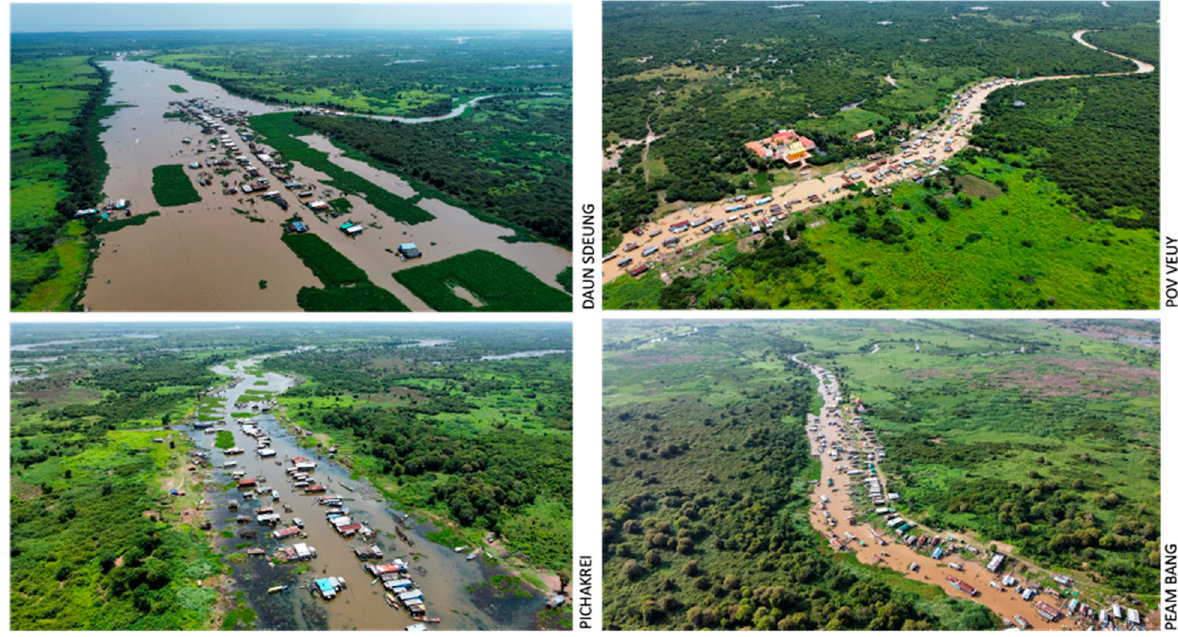
Figure 7. Subtle differences of land − water − vegetation compositions. The widths of the waterways and the microtopography greatly influences the configuration of the villages. (Linh Vu, April 2022).